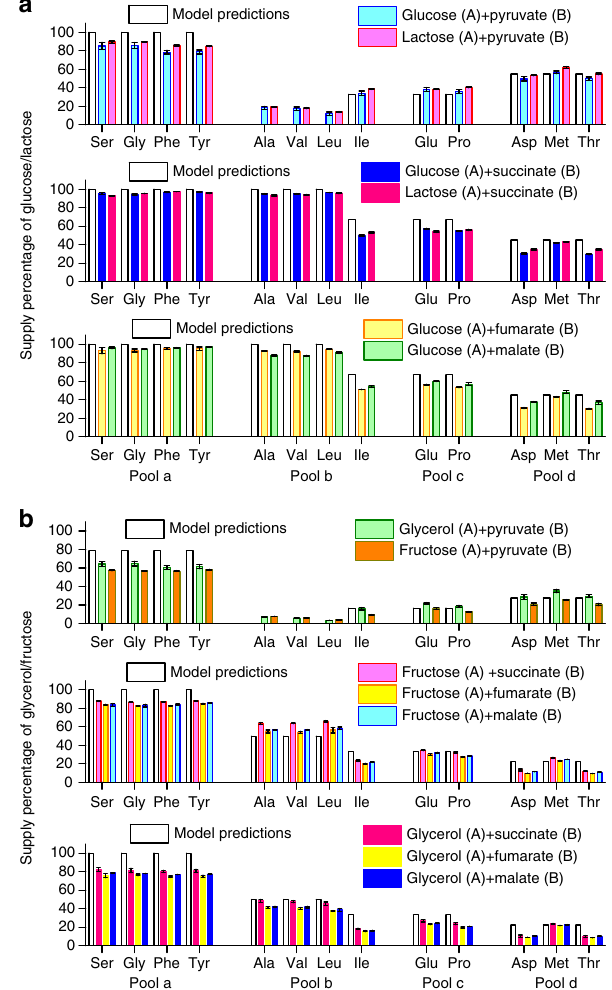
Fig. 3 Suppliers of precursor pools in A + B cases. Vertical axes are the percentages of the carbon atoms from the fi rst of the two sources indicated. Model predictions (in hollow bars, see Supplementary Table 4) are shown together with experimental results (in color bars). The source supplier of representative amino acids in Pools a – d was measured using 13 C labeling (raw data from M-57 fragment; see Methods for details). Error bars represent standard deviations. Source data are provided as a Source Data fi le. a Glucose or lactose mixed with a Group B carbon source. b Fructose or glycerol mixed with a Group B carbon